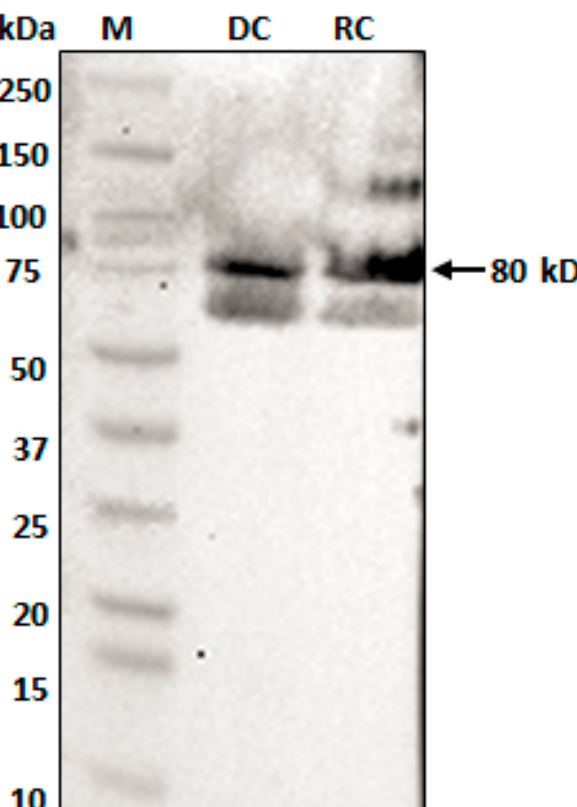
Figure 6. ECH_0379 antiporter expression assessed in RC and DC forms of E. chaffeensis cultured in vitro. Density gradient-purified fractions of RC and DC forms were used to recover E. chaffeensis proteins and were subjected to Western blot analysis using polyclonal sera raised against ECH_0379 recombinant protein. (M, protein molecular weight markers; DC and RC refer to purified E. chaffeensis proteins recovered from DC and RC fractions, respectively.)